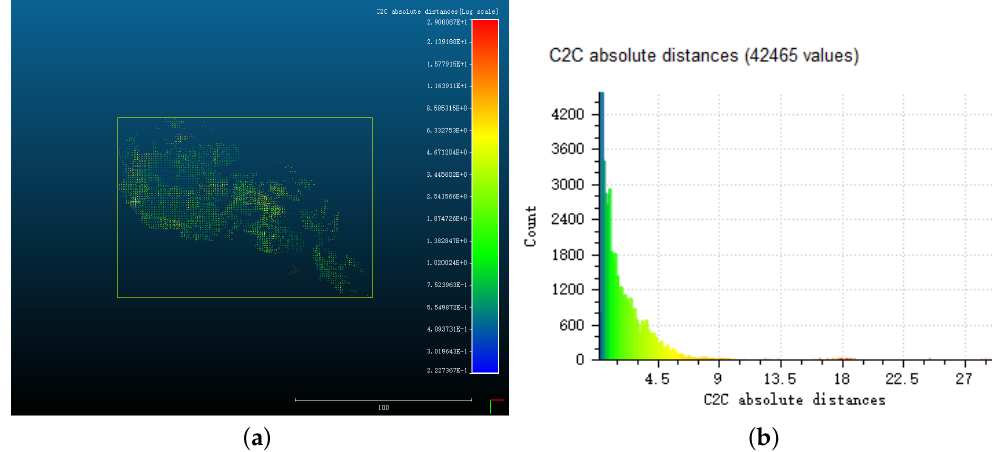
Figure A7. ( a ) Point cloud obtained by our method and graphical representation of spatial differences